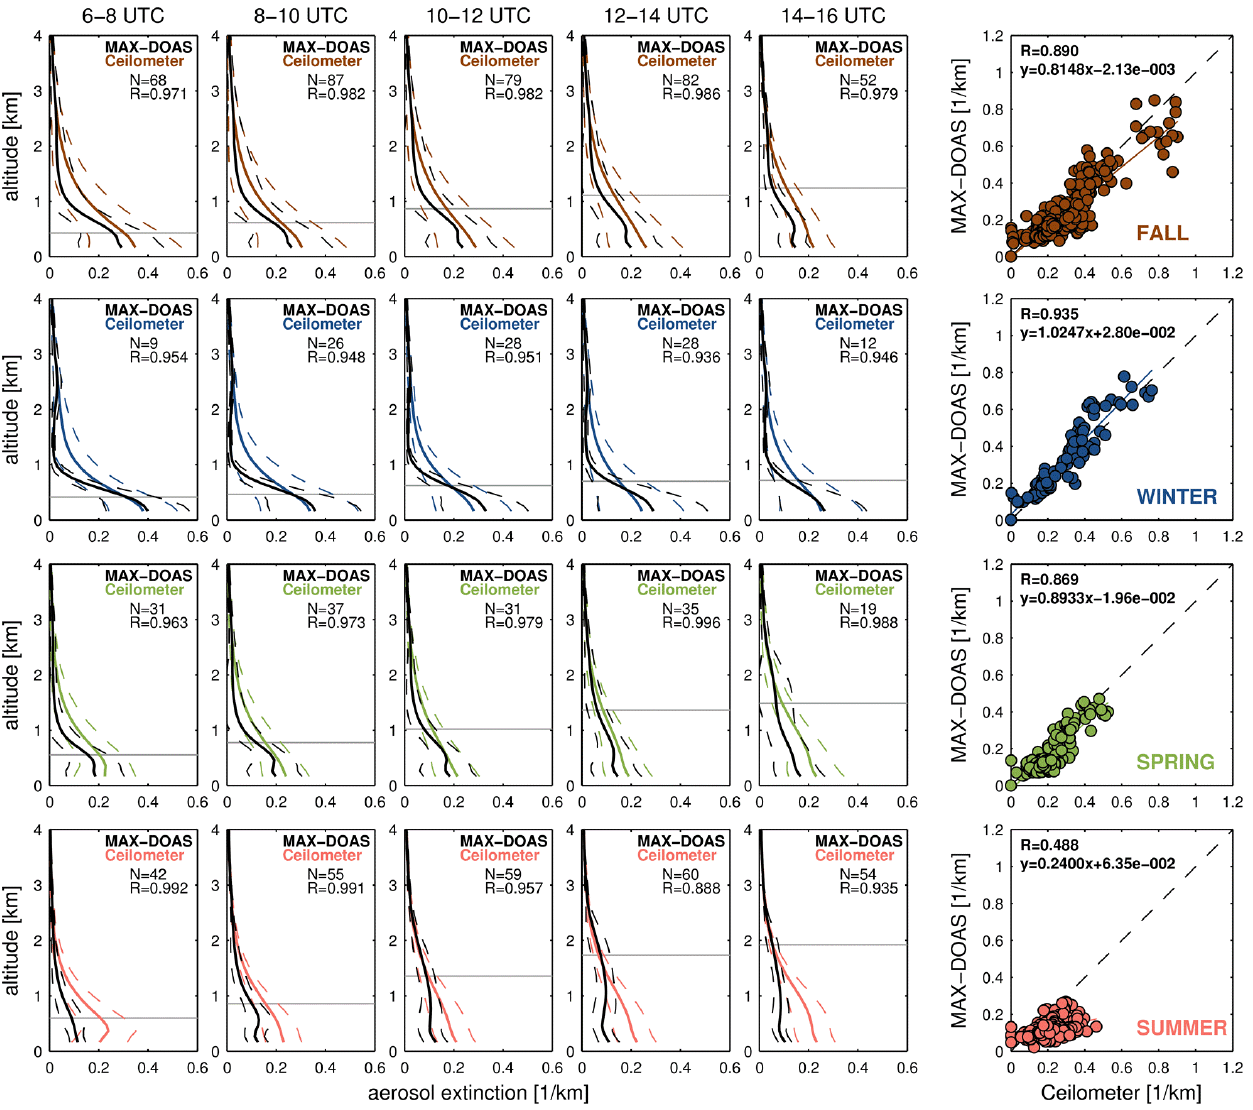
Figure 5. Averaged vertical AE (km − 1 ) profiles retrieved from BOKU MAX-DOAS (B; see Fig. 1) at 74 ◦ azimuth angle (black solid lines) and ceilometer (Z; see Fig. 1) (color-coded solid lines) observations (left panels) for selected time periods and the four seasons fall (SON), winter (DJF), spring (MAM), and summer (JJA). The dashed black and color-coded lines represent the standard deviation of MAX-DOAS and ceilometer-averaged vertical AE profiles, respectively. The gray horizontal lines illustrate corresponding averages of mixing heights from ceilometer measurements. Scatterplots of MAX-DOAS and ceilometer near-surface AE for the different seasons are shown in the right panels. Data of cloud-free days as defined in Sect. 2.2.4 between 1 September 2017 and 31 August 2019 are included. The measurements shown here are representative for the UV channel (MAX-DOAS: 338–370nm, ceilometer: